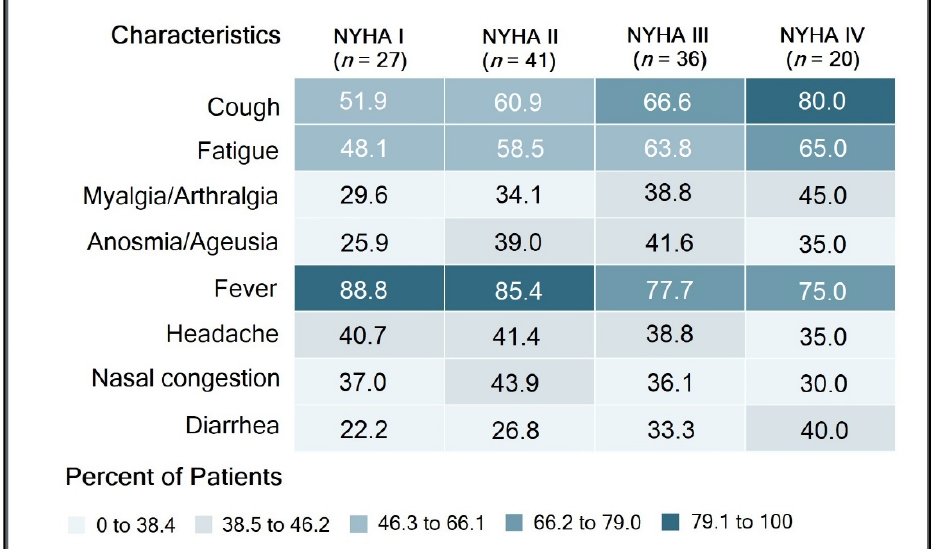
Figure 1. Comparison of signs and symptoms by NYHA classification of heart failure hospitalized patients with COVID-19. Table 3. Comparison of inflammatory markers by NYHA classification of hospitalized heart failure patients with COVID-19.